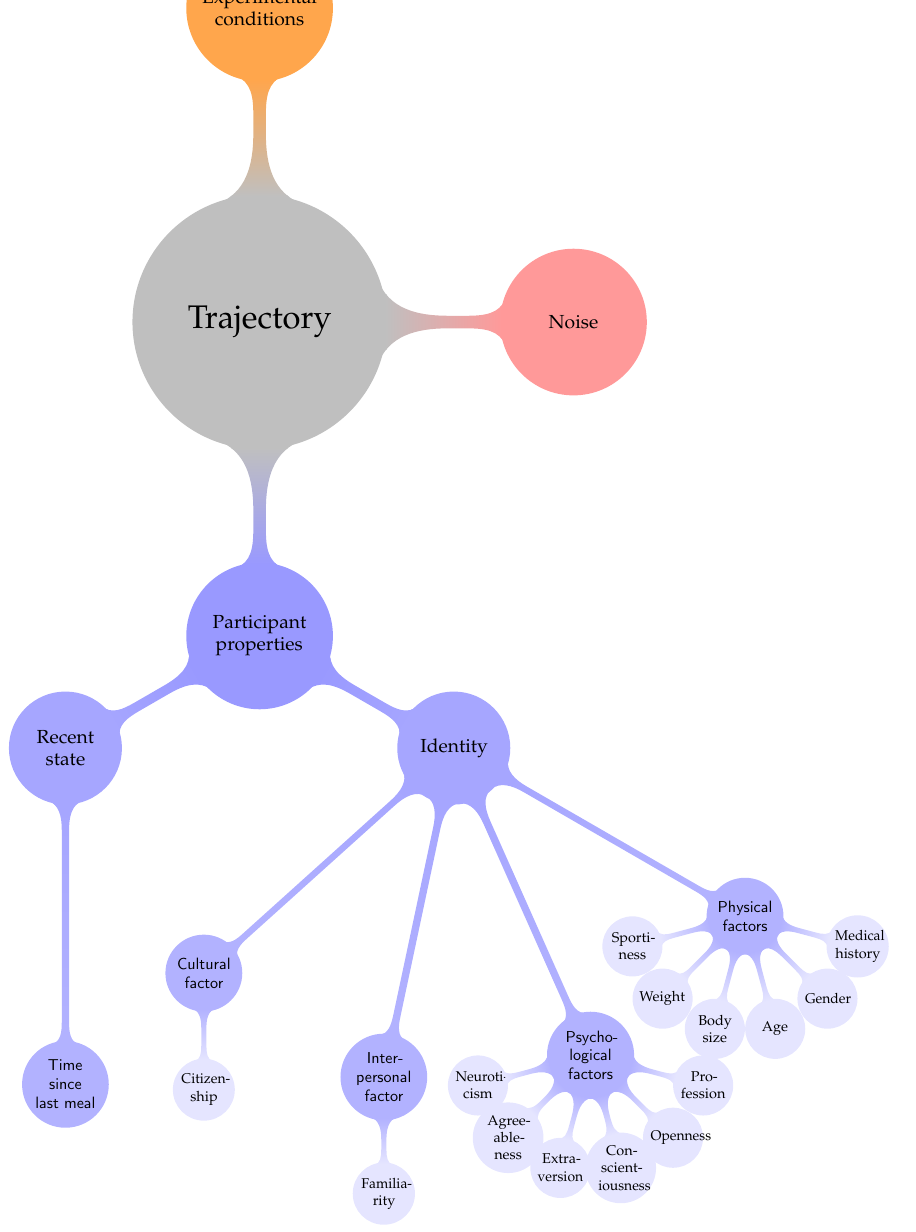
Figure 1. Tentative hierarchy of the factors, which could have an influence on the